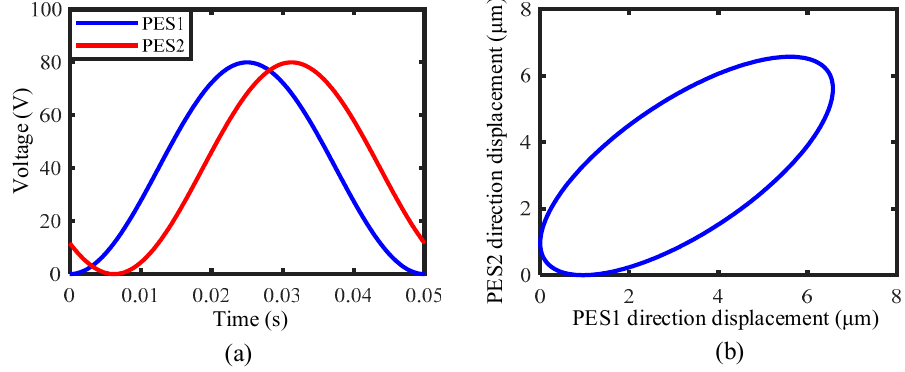
Figure 11. An example showing the generation of elliptical trajectory: ( a ) two sine-wave driving voltages with the same amplitude and frequency but a phase difference of 45°, and ( b ) the resultant elliptical trajectory.